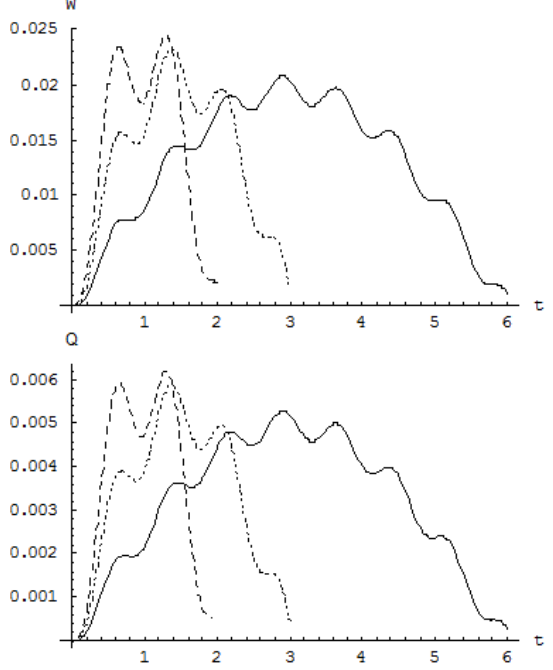
Figure 10: The influence of the speed for R = 100 m, e H = 3 m, e V = 1.20 m, and υ = 10 m/s ( ___ ), υ = 20 m/s (......), υ = 30 m/s ( - - -